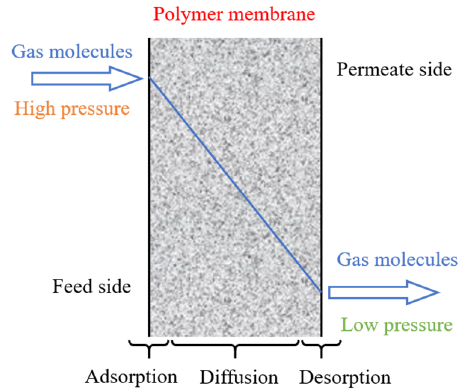
Figure 5. A schematic diagram of the solution-diffusion process.